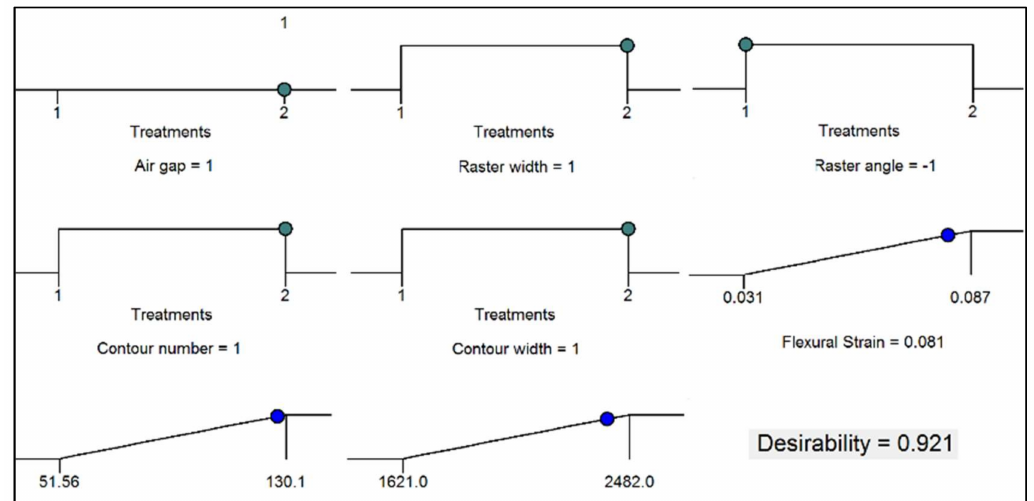
Figure 20. Optimal parameters’ combination with the predicted optimal responses.